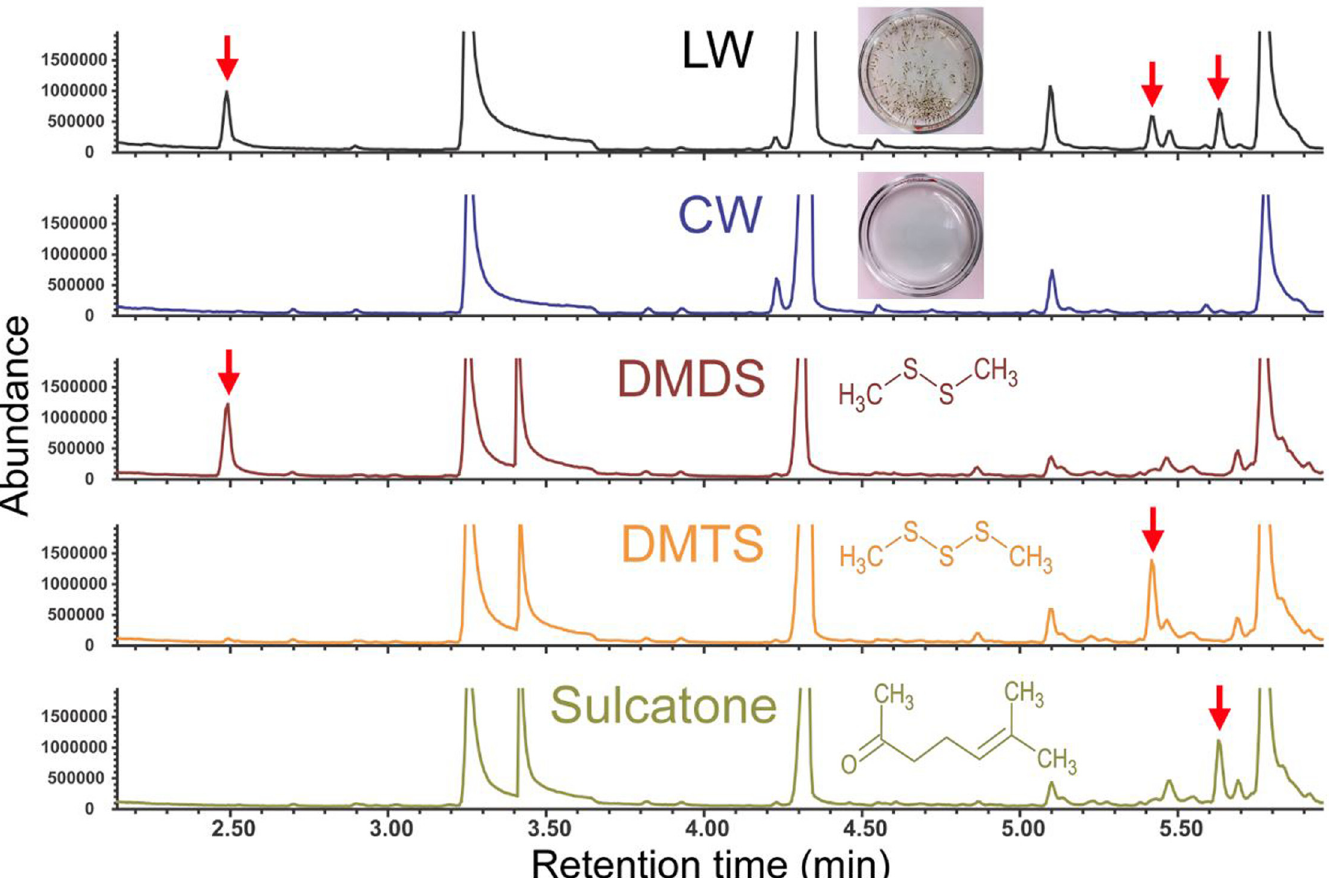
Fig 2. DMDS, DMTS and sulcatone are significant volatile components in the headspace of larval water samples. Partial chromatograms are shown for volatile samples taken from larval water (LW), control water (CW), and standard DMDS (10 -7 M), DMTS (10 − 8 M) and sulcatone (10 − 8 M) using SPME headspace analysis coupled with gas chromatography – mass spectrometry. Peaks for DMDS, DMTS and sulcatone are marked with red arrows. No additional LW specific compounds were detected beyond the retention time of sulcatone. Large peaks with retention times of approximately 3.2, 4.3 and 5.8 min represent impurities possibly introduced during sample preparations and/or chemical analyses, which are present in all samples including LW and CW.